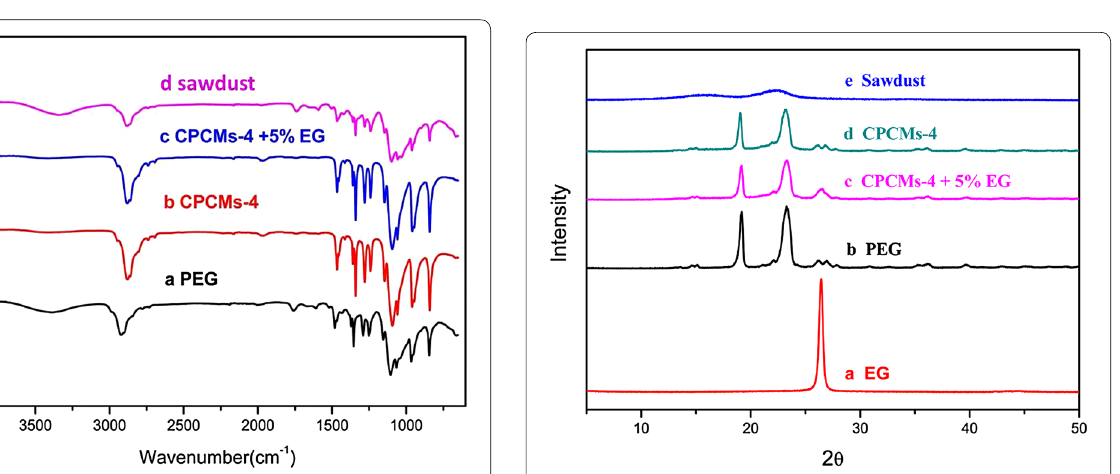
Fig. 2 The FTIR spectrum of (a) PEG, (b) CPCMs‑4, (c) CPCMs‑4 with 5% EG, and (d) waste sawdust